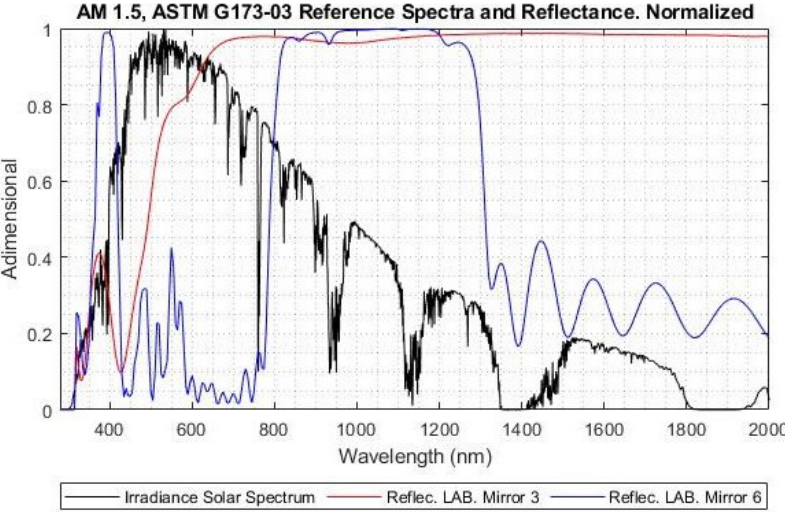
Figure 8. Spectral reflectance of mirrors #3 and #6 together with the irradiance of the standard AM1.5 solar